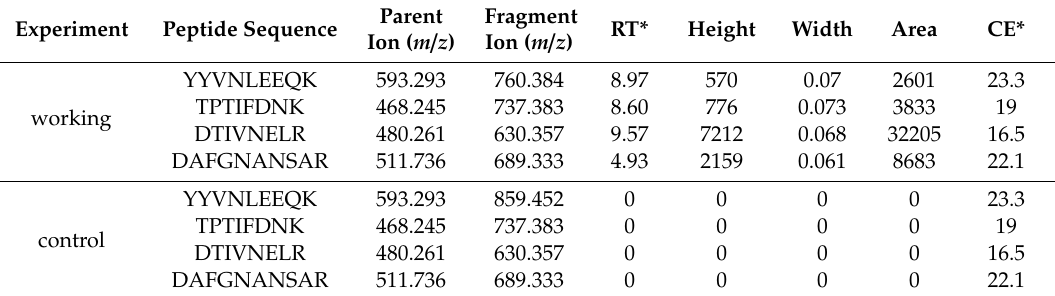
Table 1. The list of transitions for selected reaction monitoring (SRM) analysis, obtained in experiments with DSP-activated (working experiment) and non-activated (control experiment) AFM substrate surface incubated in 10 − 9 M HRP